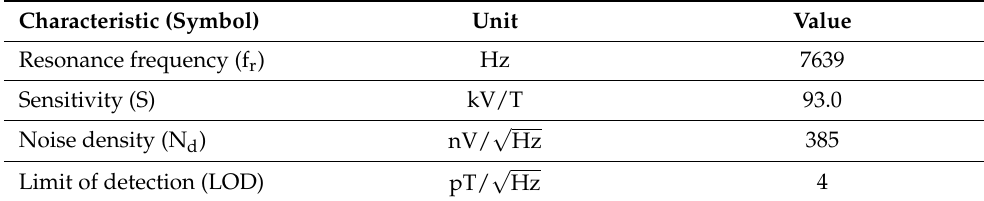
Table 1. Magnetoelectric sensor